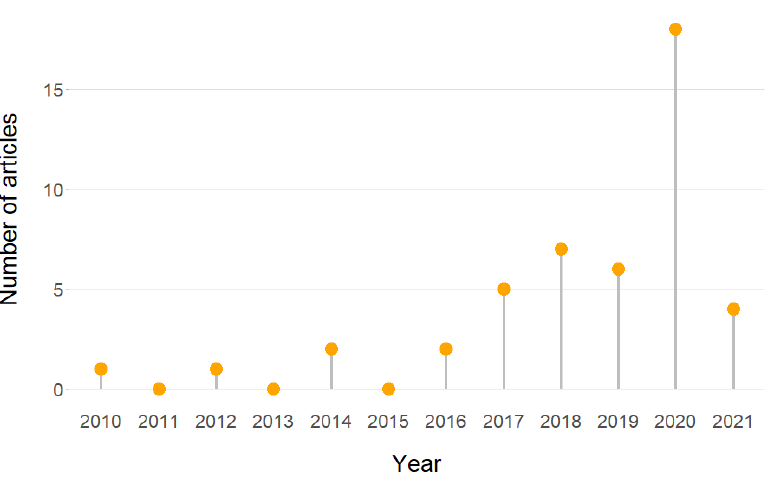
Figure 4. Distribution by year of articles included in the